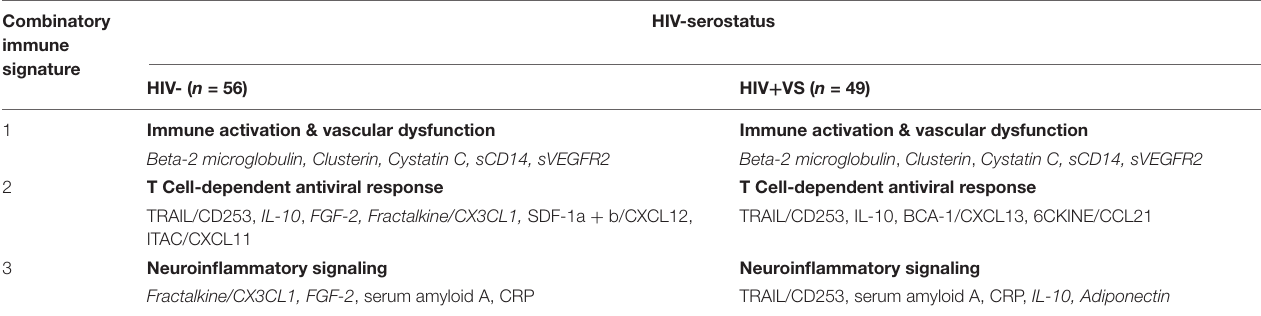
TABLE 2 | Strongest network of inflammatory markers contributing to Combinatory Immune Signature that were common between HIV-uninfected (HIV-) women and virally suppressed women with HIV (HIV + VS).